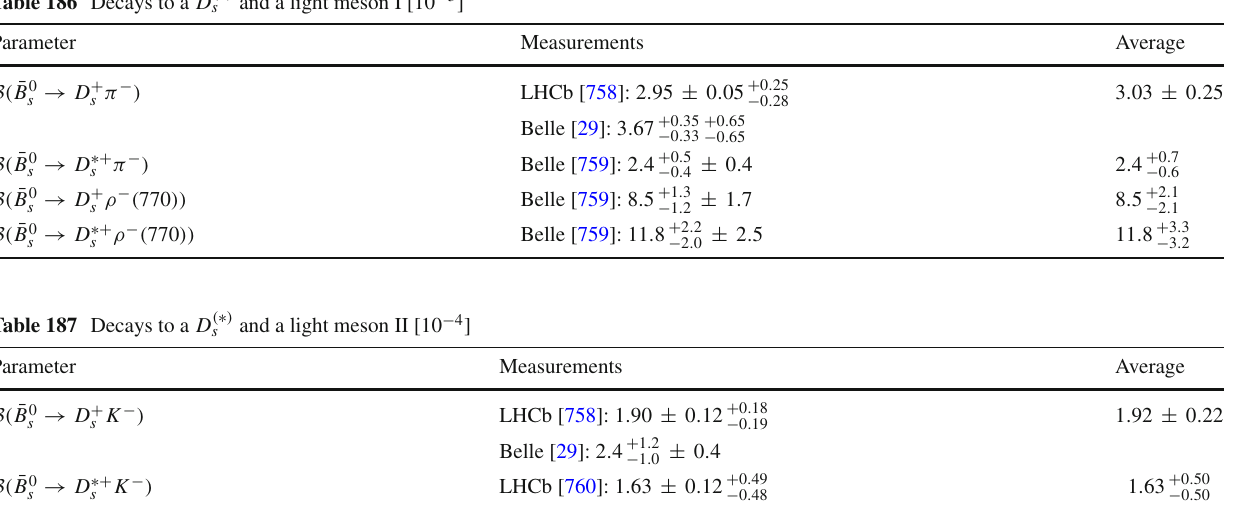
( ∗ ) s and a light meson I